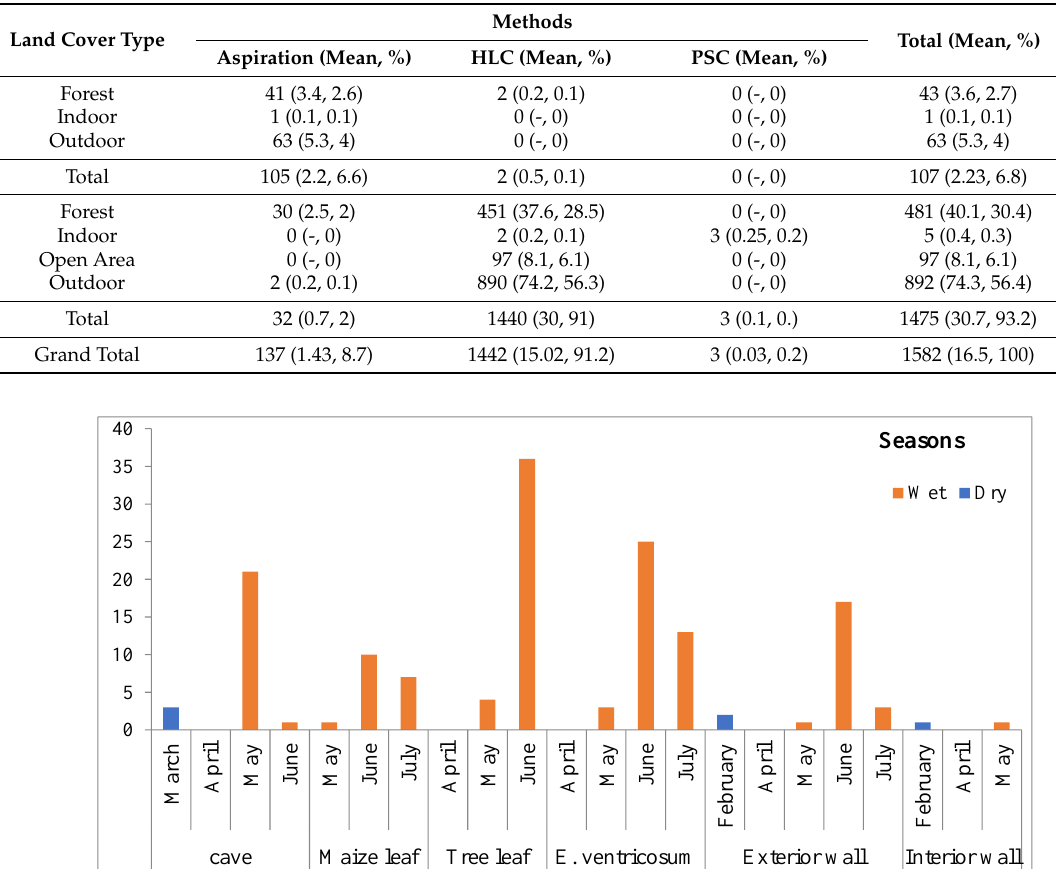
Table 1. Mosquito species composition and seasonal distribution in Ofa and Boko Dawula districts, southwestern Ethiopia . Table 2. Abdominal condition of Ae. simpsoni complex from different collection sites by different entomological sampling techniques in southwestern Ethiopia.